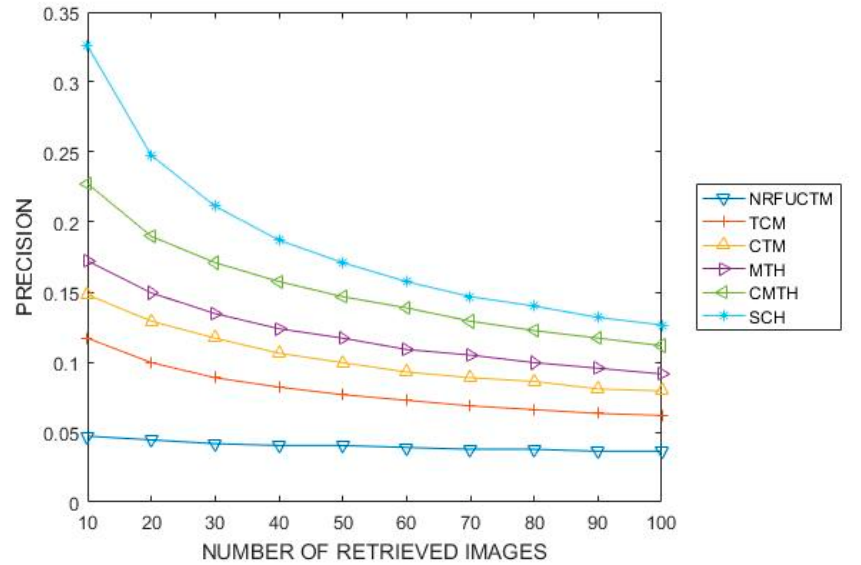
Figure 7. Performance of SCH compared with textons on Corel-10K .